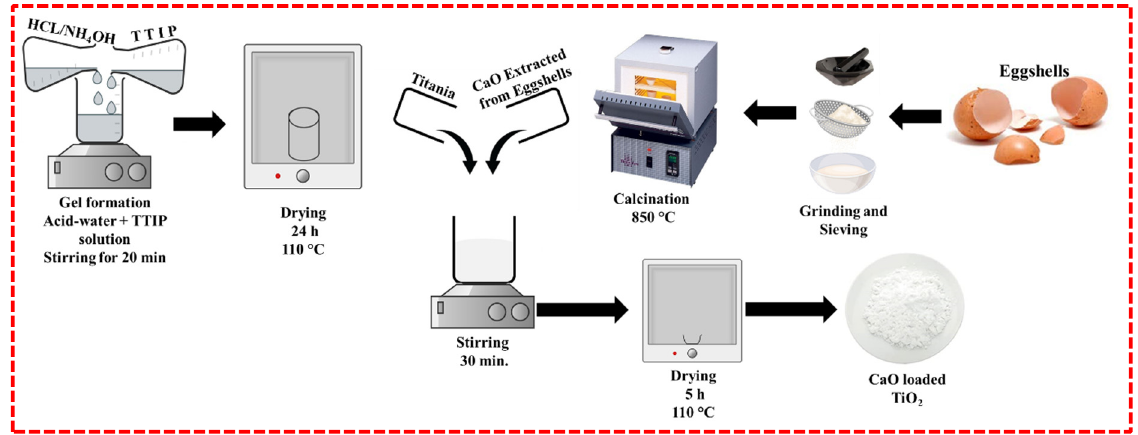
Figure 11. Schematic representation of synthesis of CaO decorated TiO 2